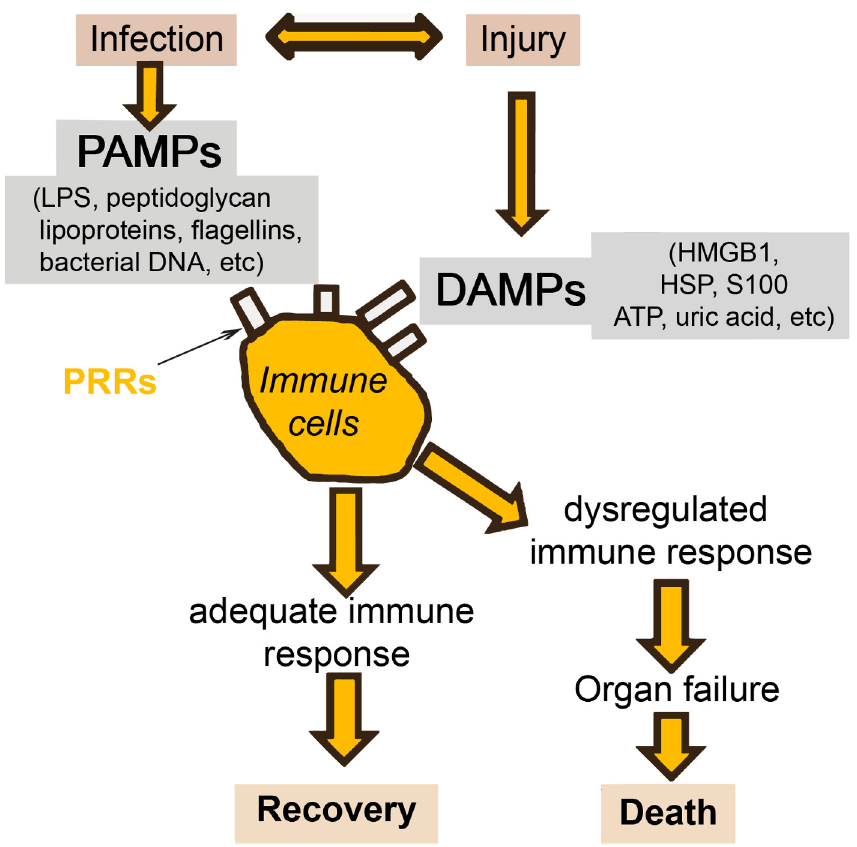
Fig 3. Simplification of the host response to an infection. Injury (via DAMPs) and infection (via PAMPs) can stimulate the same inflammatory reaction via the PRRs. HMGB: high mobility group box protein; HSP: heat shock